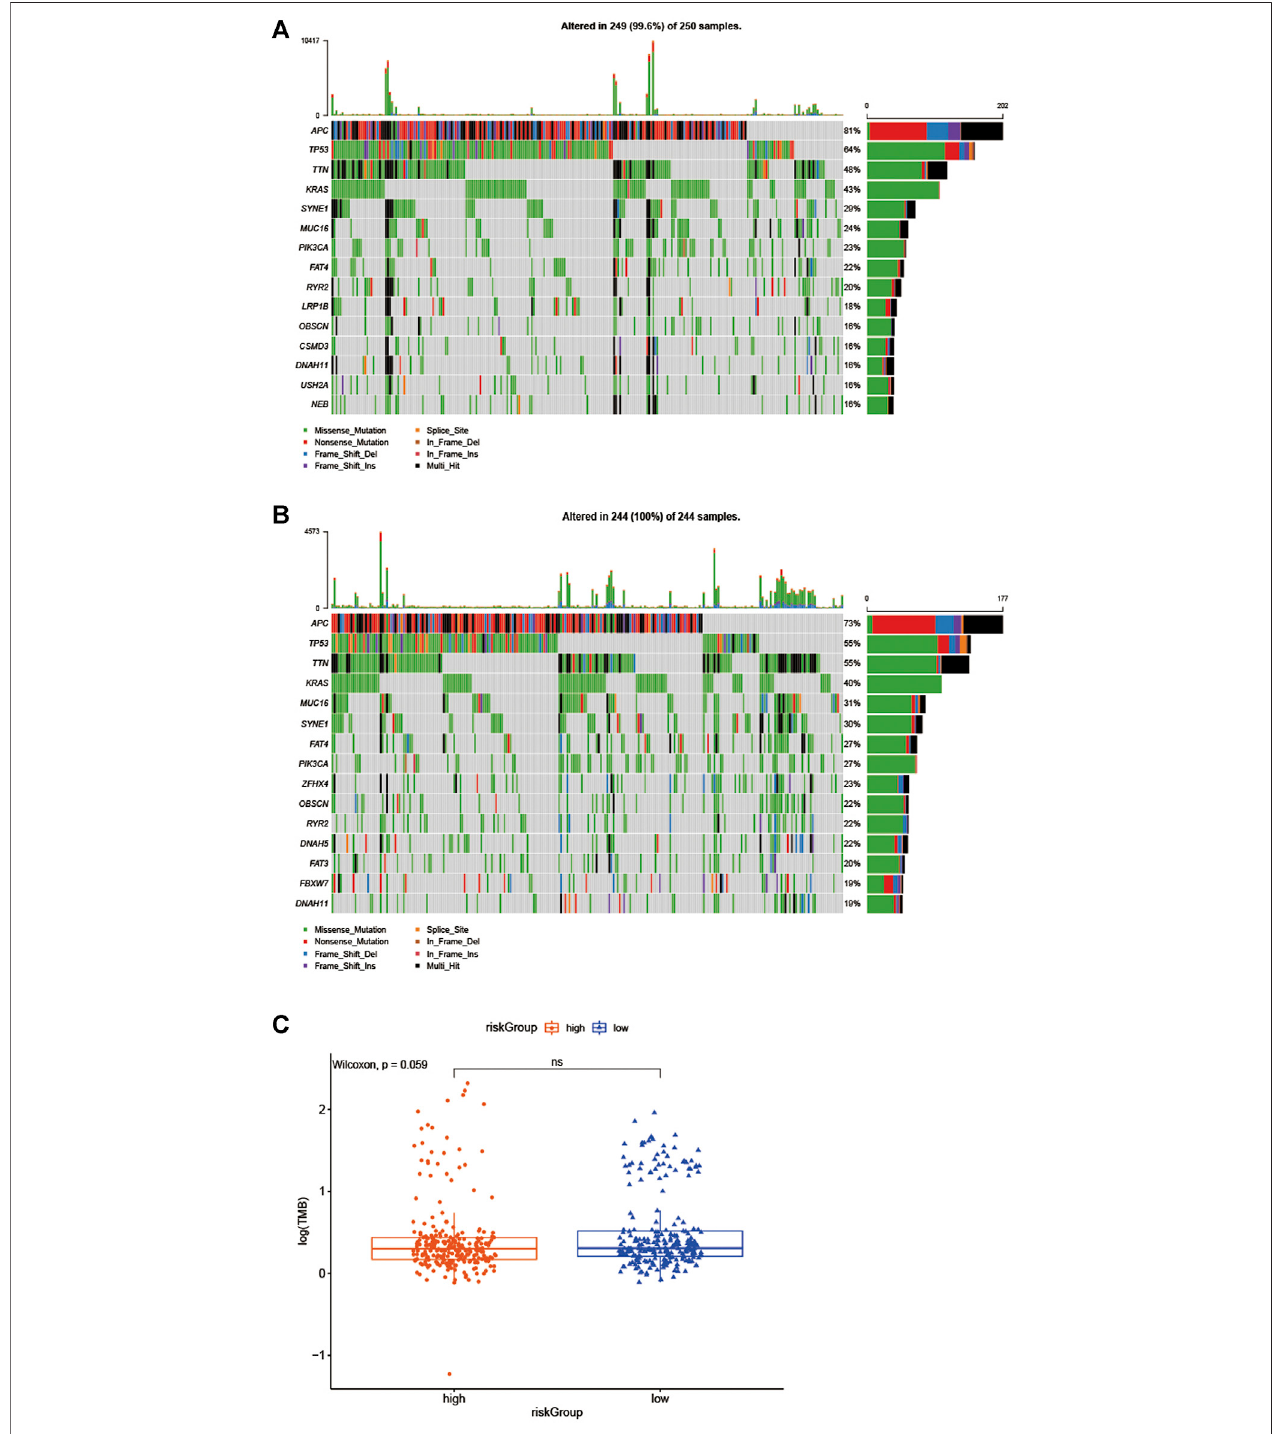
FIGURE6| Biologicalinsightintothehigh-andlow-riskgroup. (A,B) signi fi cantlymutatedgenesinthemutatedCRCsamplesofthehigh-andlow-riskgroups. (C) The proportions of TME cells in the high - and low-risk groups.